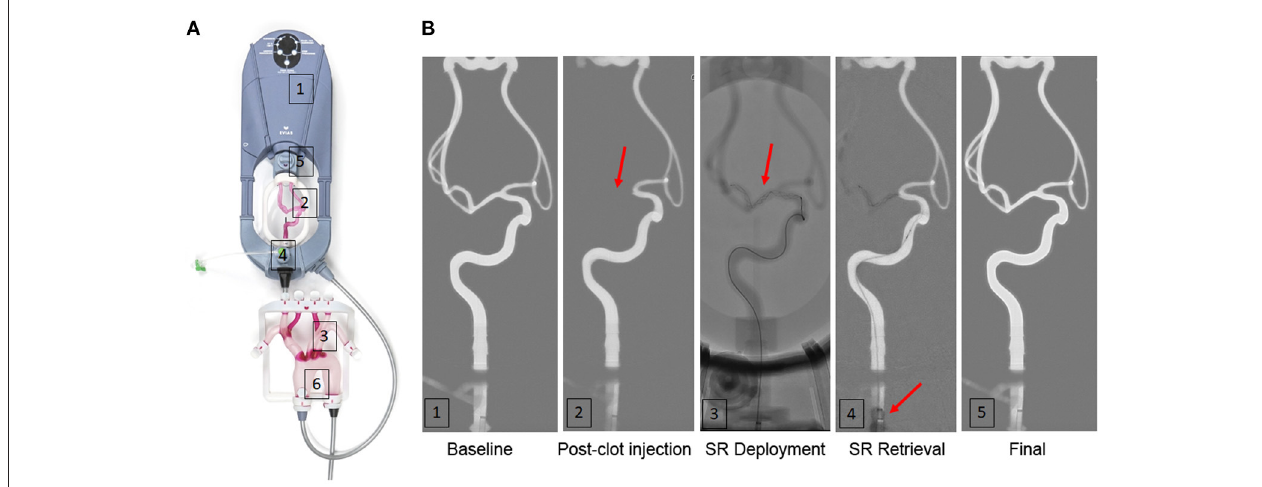
FIGURE 1 | A simulation model for thrombectomy of in flow-injected human thrombi. (A) Overview of the EVIAS PlusTM System. (1) a plug-and-play station pump (2) an intracranial artery cartridge; (3) an aortic arch; (4) a thrombus injection system; (5) a distal thrombus filter (700 µ m mesh); (6) fluid pressure monitoring outlet. (B) processed fluoroscopy imaging of one simulated endovascular therapy (EVT) showing baseline (1), immediately after in flow thrombus injection with M1 occlusion (red arrow) (2), after the stent-retriever deployment (3), during stent-retriever retrieval after proximal balloon inflation (red arrow) (4) and final control (5). SR, stent